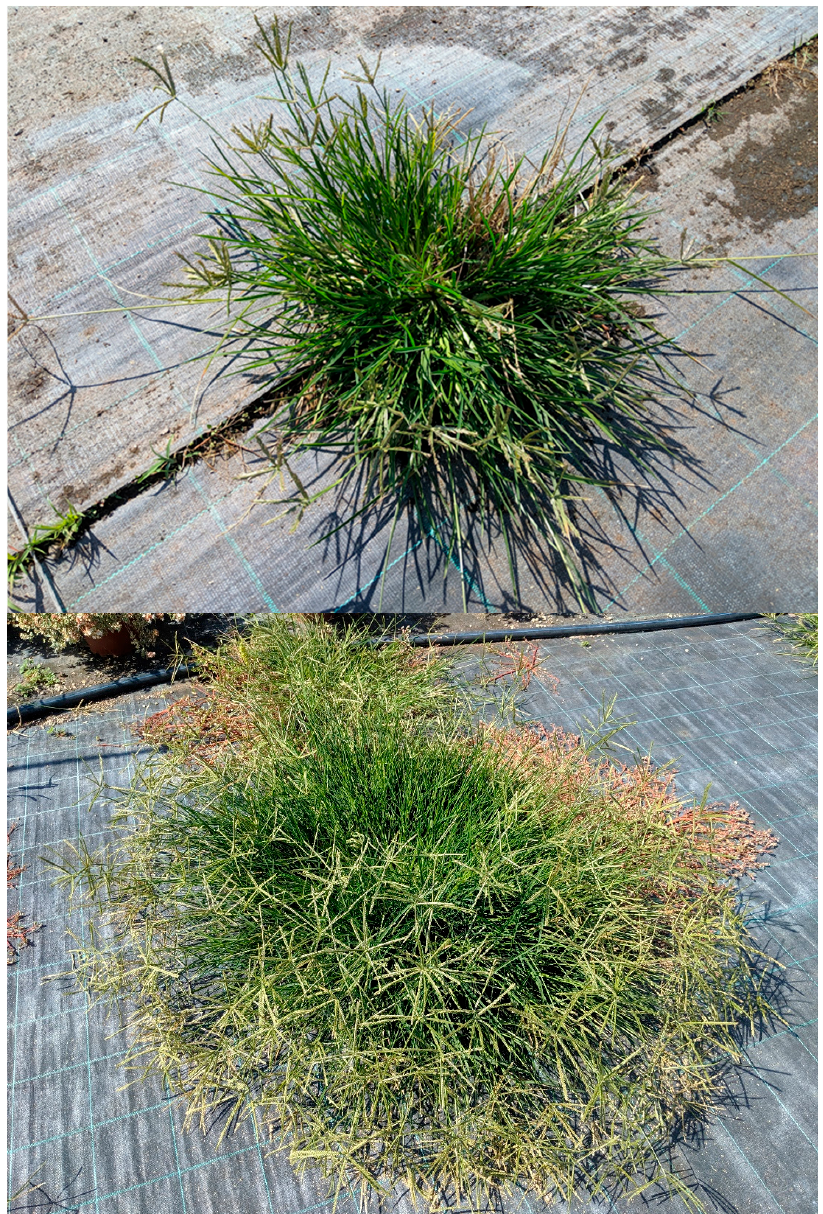
Figure 1. Plants of Eleusine indica (L.) Gaertn. that emerged from holes and gaps of plastic mulches. These plants were survivors to repeated glyphosate applications.